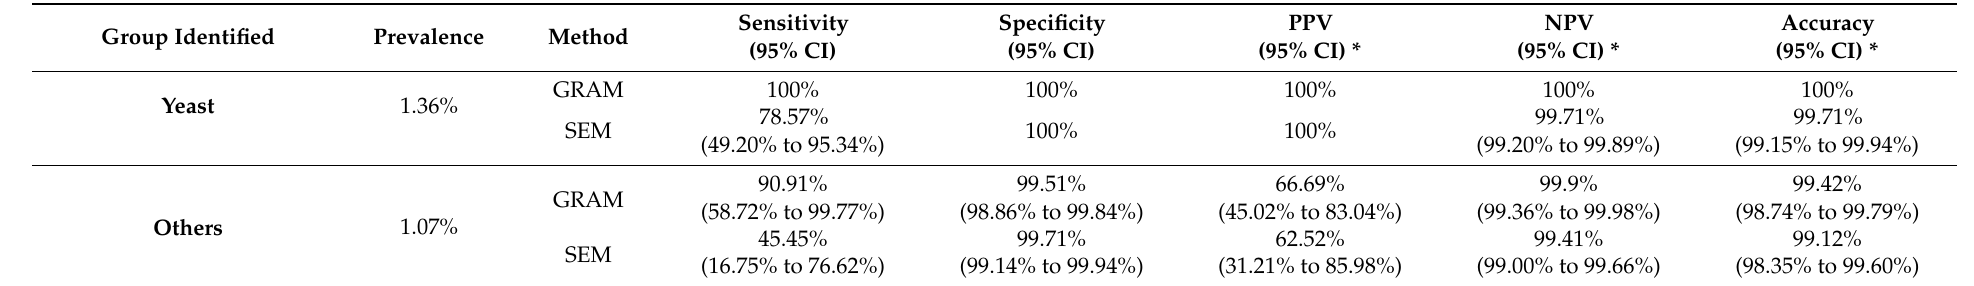
Table 3. Performance characteristics for other microbe identification using SEM vs. Gram staining with culture-based MALDI-TOF/MS identification as a reference. Group